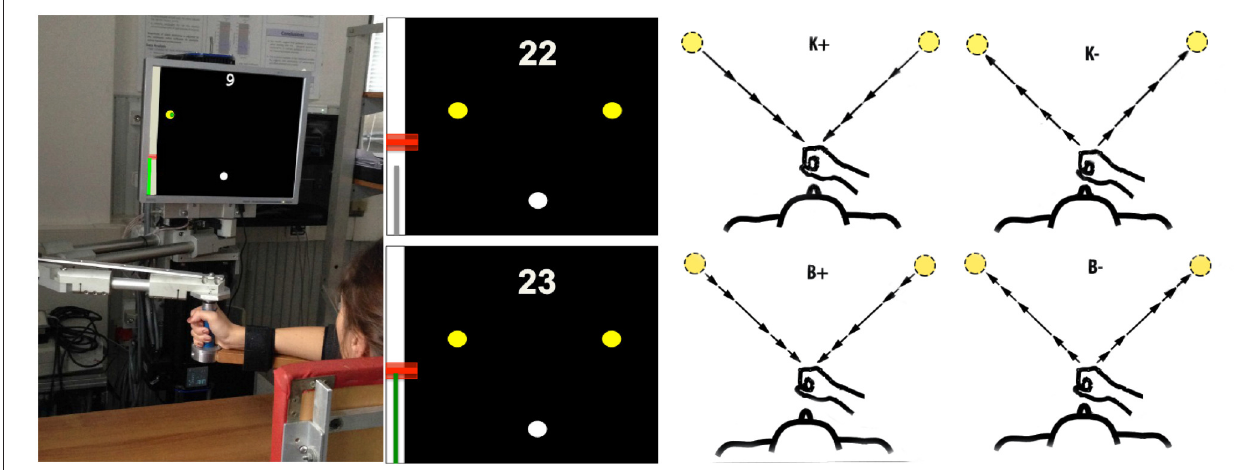
FIGURE 1 | Experimental apparatus and task. Left: Experimental set-up. Middle : Screenshots illustrating the movement task, including the starting point (white circle), the two targets (yellow circles), the performance score and the feedback on target and actual speed. Right: Force field types. From top to bottom and left to right: K + , K − , B + , B − . The arrows lengths denote force magnitude. In the position-dependent case, forces are directed toward (K + ) or away (K − ) from the start position and their magnitude increases with distance from the starting position. In the velocity-dependent case, forces are directed like the velocity vector (B − ) or in the opposite direction (B + ). Force magnitude is greater at peak